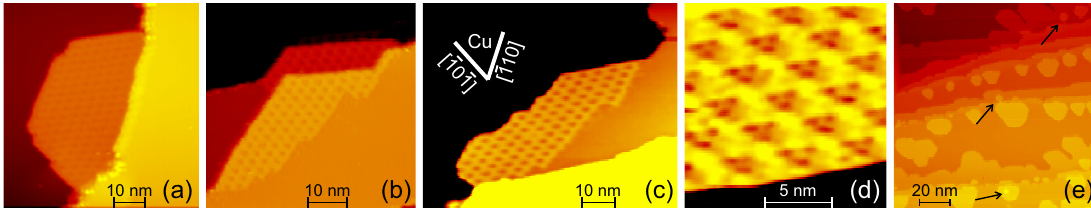
Figure 1. Ag/Cu(111) grown above 200 K: ( a – d ) STM images at increasing resolution for room temperature growth; Cu (cid:104) 110 (cid:105) directions as determined from images of atomic resolution are identical for all images ( e ) grown at 230 K, arrows point to second layer nucleation; deposition